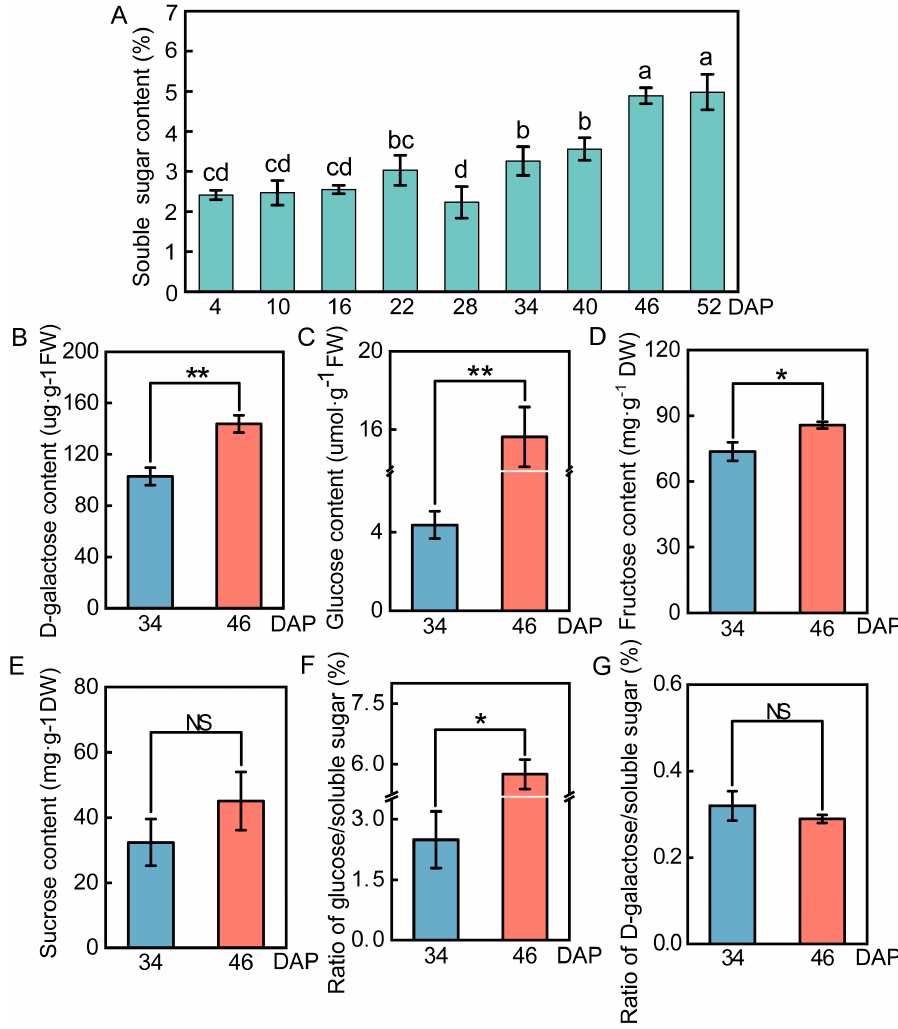
Figure 1. Sugar content in wucai leaves. ( A ) Soluble sugar content (%). ( B ) D-galactose content ( µ g · g − 1 FW). ( C ) Glucose content ( µ mol · g − 1 FW). ( D ) Fructose content (mg · g − 1 DW). ( E ) Sucrose content (mg · g − 1 DW). ( F ) Ratio of glucose/soluble sugar. ( G ) Ratio of D-galactose in/soluble sugar. FW and DW meant fresh weight and dry weight, respectively. Values presented are the mean ± SE (n ≥ 3), and bars with different letters represent significant differences at p < 0.05. * and ** meant p < 0.05 and p < 0.01, respectively. NS indicated no significant difference.